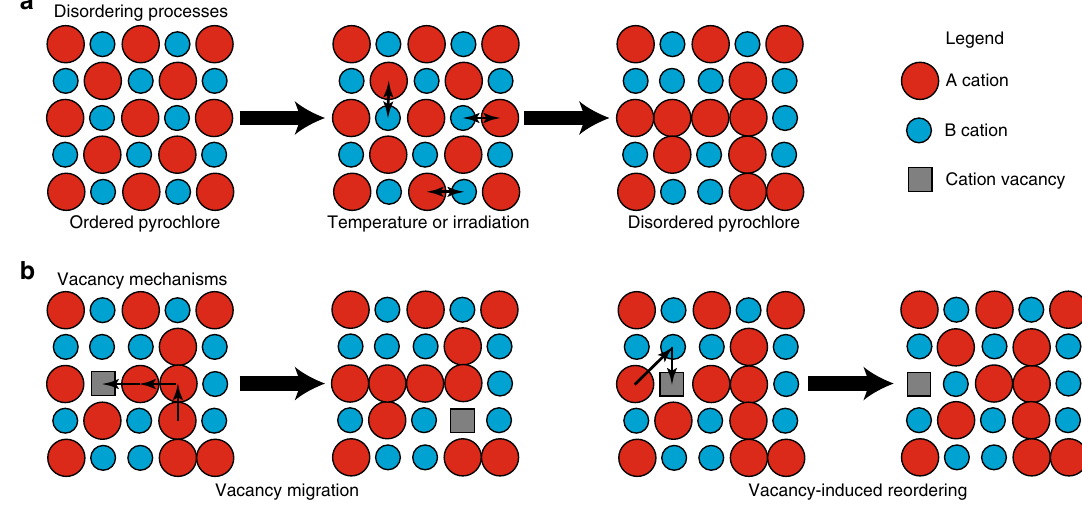
Fig. 1 Schematic of the disordering processes and vacancy mechanisms in pyrochlore examined in this manuscript. a Disordering processes. b Vacancy mechanisms. Oxygen ions omitted for clarity. In b , the schematic mechanisms consist of multiple ion moves that, in reality, might be described by multiple saddle